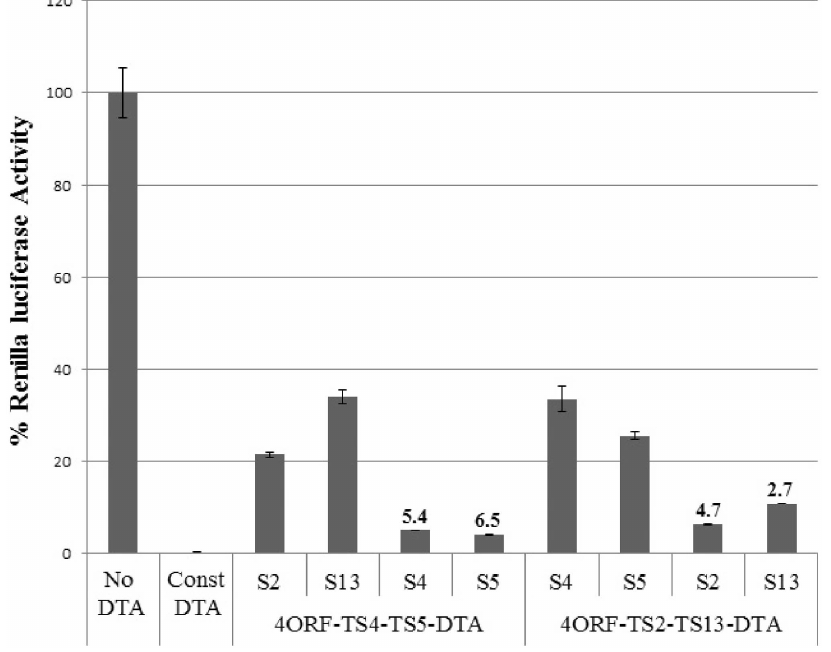
Fig. 4. Reciprocal DTA activation by exogenous siRNAs in HEK293T cells. HEK293T cells (1.1 6 10 5 ) were transfected with the indicated DTA construct (30 ng), a luciferase reporter plasmid (170 ng) and the indicated siRNA (10 pmol). The renilla luciferase activity of the ‘‘No DTA’’ construct was set as 100% and the luciferase activity obtained for all other constructs were compared to the No DTA level. The ‘‘Const DTA’’ construct had no UIR, with the DTA transgene directly driven by the CMV promoter. The siRNA used were: s4: siRNA S4; s5: siRNA S5; s2: siRNA s2; s13: siRNA S13. SiRNAs S2 and S13 served as controls for the 4ORF-TS4-TS5-DTA construct and siRNA S4 and S5 served as controls for the 4ORF-TS2-TS13-DTA construct. The numbers above the bars of the targeted siRNAs indicated the DTA induction level calculated by dividing the luciferase activity of the average of the control siRNAs with that of the indicted targeted siRNA of the same set. The experiment was repeated 3 times and each experiment was done in triplicates. Statistical analysis was done by T-test and the bars represent standard error. P values are , 0.002 for S4 and S5 on the left side and S2 and S13 on the right